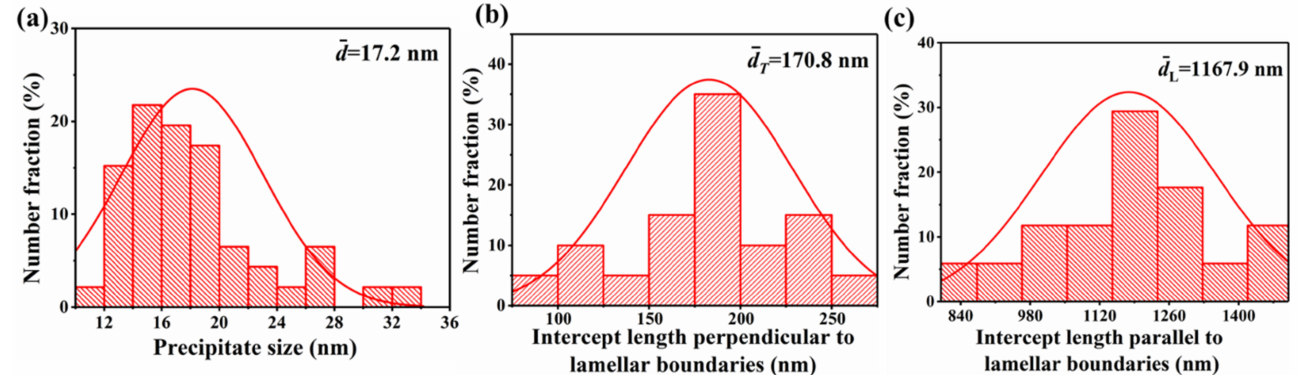
Figure 5. Statistical-distribution diagram of 150 ◦ C-annealed alloy: ( a ) the average size of T- Mg 32 (Al,Zn) 49 phase, ( b ) intercept length perpendicular to lamellar boundaries, ( c ) intercept length parallel to lamellar boundaries.